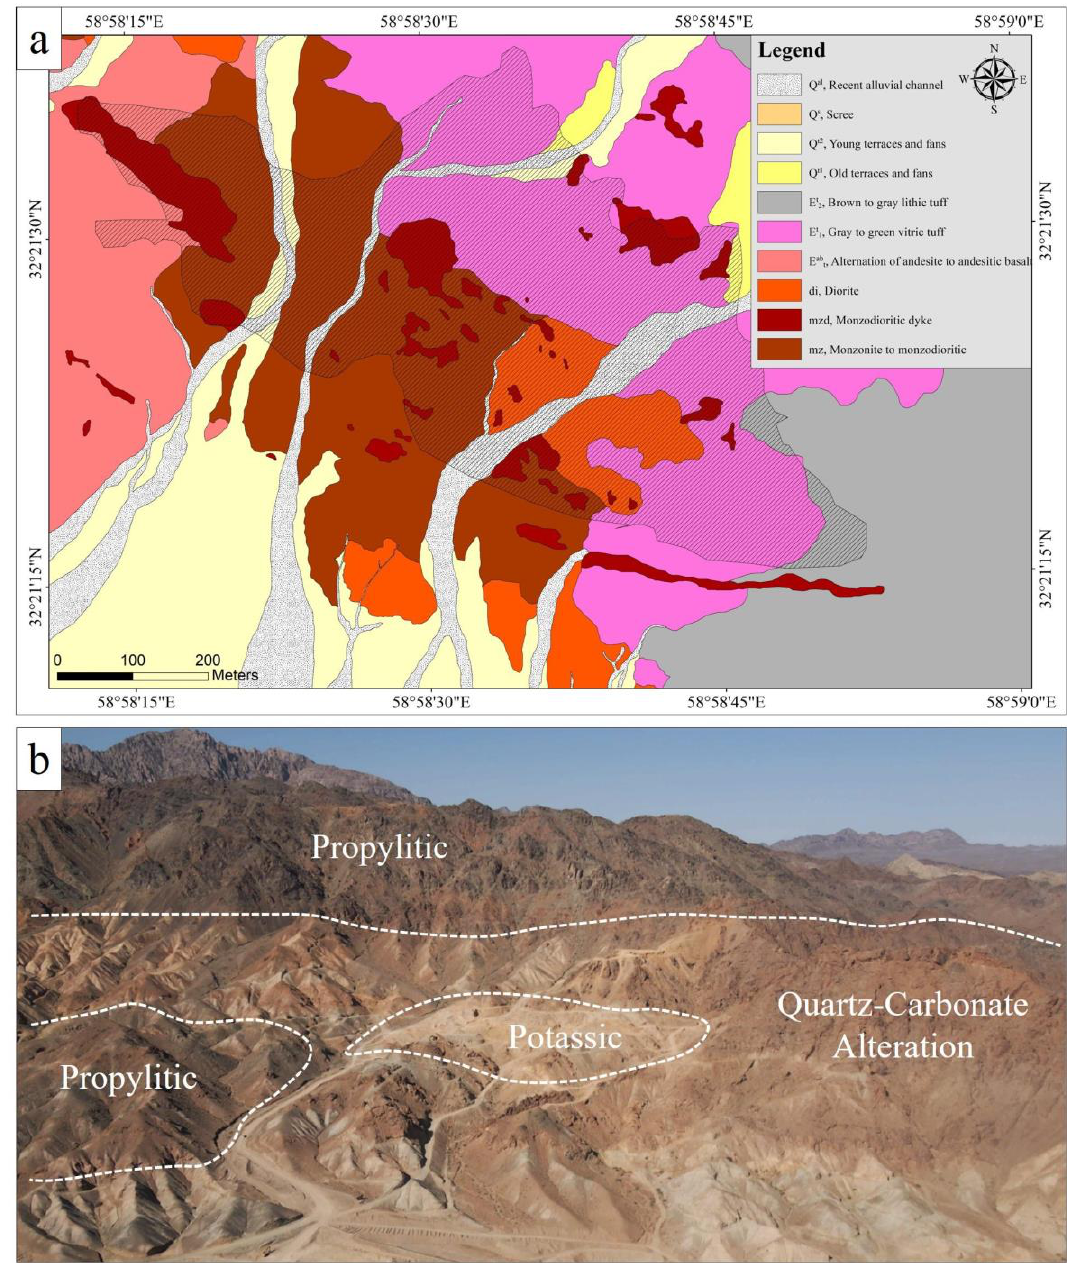
Figure 4. ( a ) Local geological map of Shadan porphyry gold – copper deposit. Zone of sheeted vein indicated by cross-hatching. ( b ) Aerial view of the Shadan porphyry, NW – SE mineralization zone indicated by light-colored intrusive rocks, surrounded by propylitically altered volcanic rocks.